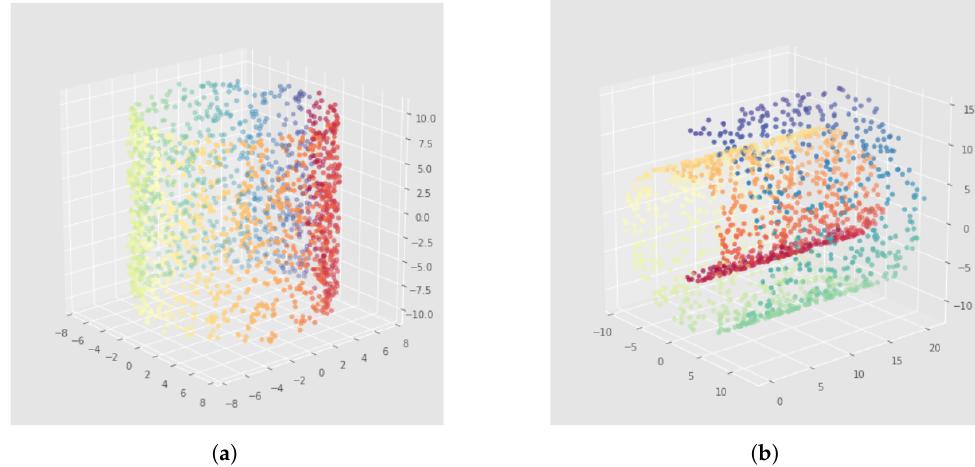
Figure 7. Open cylinder (left) and swissroll (right) training datasets. ( a ) Dataset 1: Open cylinder β 0 = 1, β 1 = 1. ( b ) Dataset 2: Swissroll β 0 = 1, β 1 =